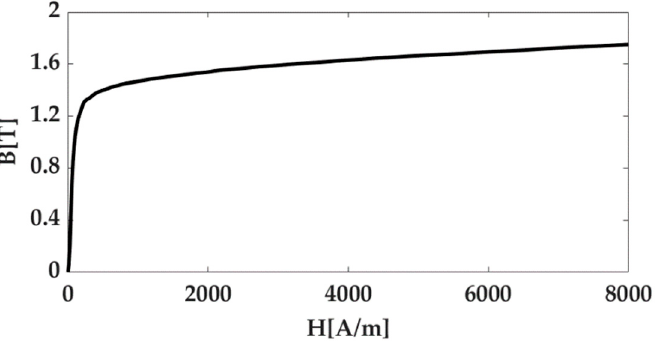
Figure 1. Concept of the C-Mag with the SCARA to generate 3-D rolling motion of a magnetic capsule.